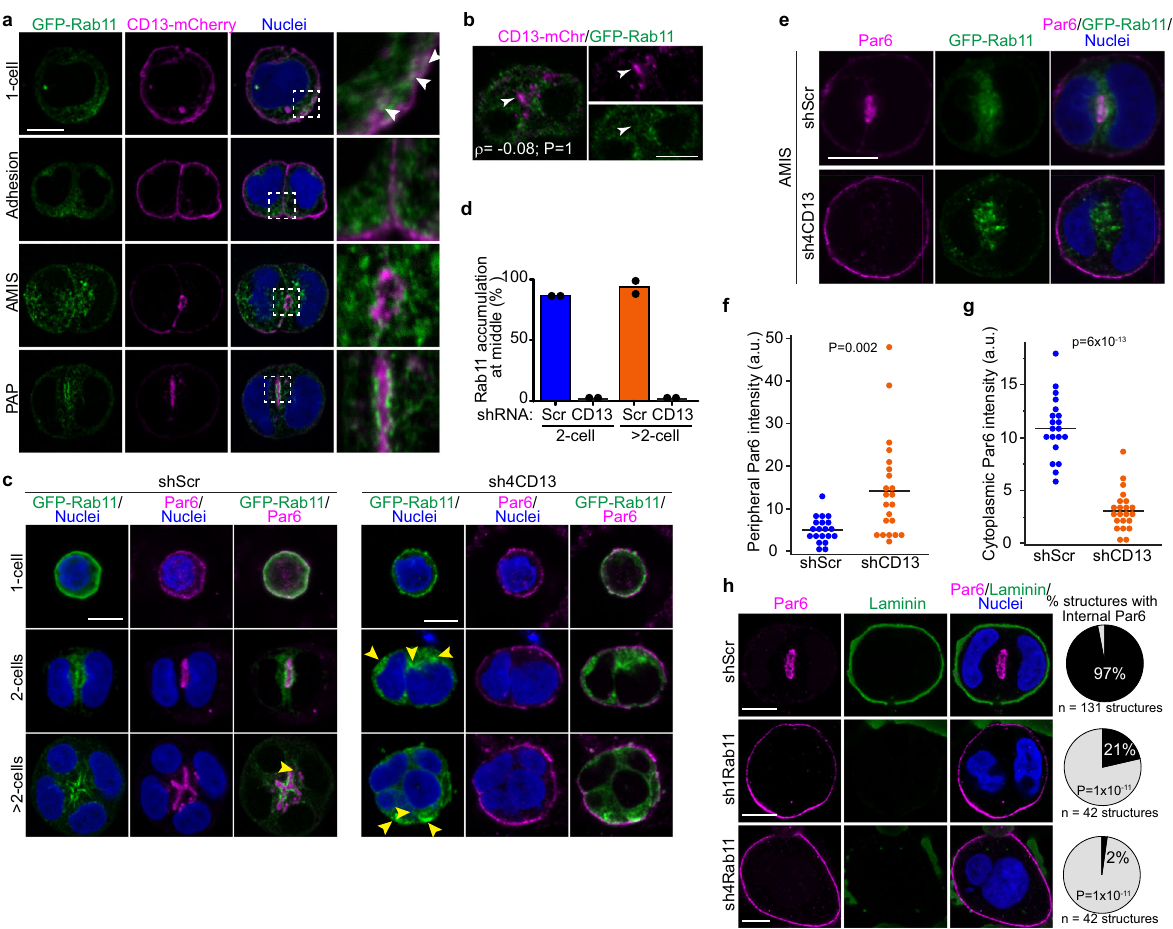
Fig. 5 CD13 Knockdown disrupts Rab11-dependent early polarization in Caco-2 cells. a Confocal images showing the localization of CD13-mCherry (magenta) and GFP-Rab11 (green) at 1-cell, and adhesion, AMIS, and PAP stage in 2-cell 3D Caco-2 structures. White arrows show the proximity of CD13 puncta with Rab11-positive vesicles near the plasma membrane. b Confocal images of Caco-2 cells showing CD13-mCh (magenta) and GFP-Rab11 (green) vesicles during AMIS formation. Object-based colocalization was performed for CD13 and Rab11, and produced a correlation ef fi cient ρ = -0.08. Arrows show local sites of CD13 accumulation. c Confocal images of GFP-Rab11 (green) and Par6 (magenta) showing their localization in shScr and shCD13 Caco-2 cells. Yellow arrows show regions of concentrated Rab11-positive vesicles. d Quanti fi cation of the percentage of Rab11 accumulation at the middle of shScr ( n = 92) and shCD13 ( n = 24) at 2 cell and >2 cell 3D Caco-2 structures. Dots represent means from each of two independent experiments. e Confocal images of 3D Caco-2 structures at the AMIS stage showing localization of GFP-Rab11 (green) and Par6 (magenta). f , g Quanti fi cation of Par6 localization to the periphery ( f ) or cytoplasm ( g ) in shScr ( n = 20) and shCD13 ( n = 22) Caco-2 cells at the AMIS stage. Dots represent individual Caco-2 structures from a single experiment. h Confocal images of control (shScr) and Rab-down (sh1-Rab11, sh4-Rab11) 3D Caco-2 cells immunostained for Par6 (magenta) and laminin (green). Right – quanti fi cation of structures with internal Par6 staining as a measure of normal or inverted polarity. The indicated number of structures were measured from ( n = 11 shScr, n = 11 sh1Rab11, and n = 9 sh4Rab11) experiments. p -values were determined by ANOVA with Tukey ’ s posthoc test for multiple comparisons ( d , h ) or unpaired two-tailed student ’ s t-test ( f , g ). Images are representative from two ( c ) or three ( a , b , e , h ) independent experiments. Bars: 10 μ